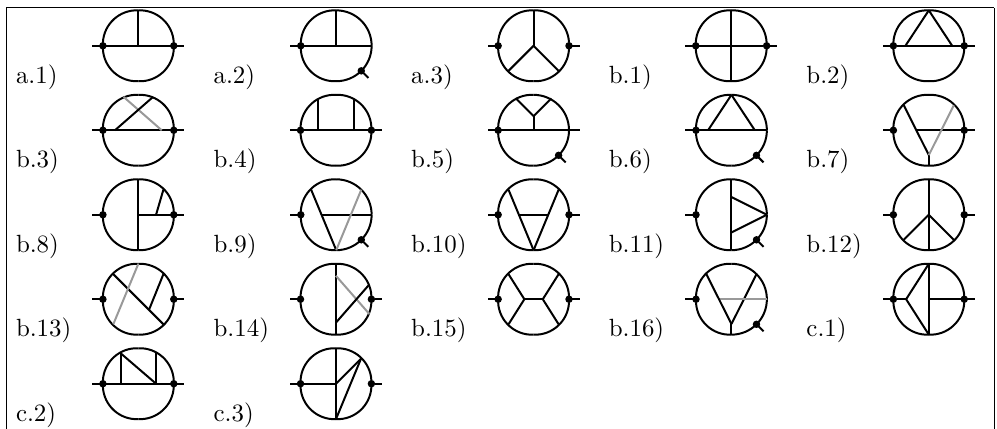
Table 2. List of scalar supergraphs whose corresponding cross-section contribution is computed in 3. They are divided in three series: a) 3-loop supergraphs, b) 4-loop supergraphs, c) 5-loop supergraphs. Grey edges and black edges do not intersect each other, but overlap due to the planar